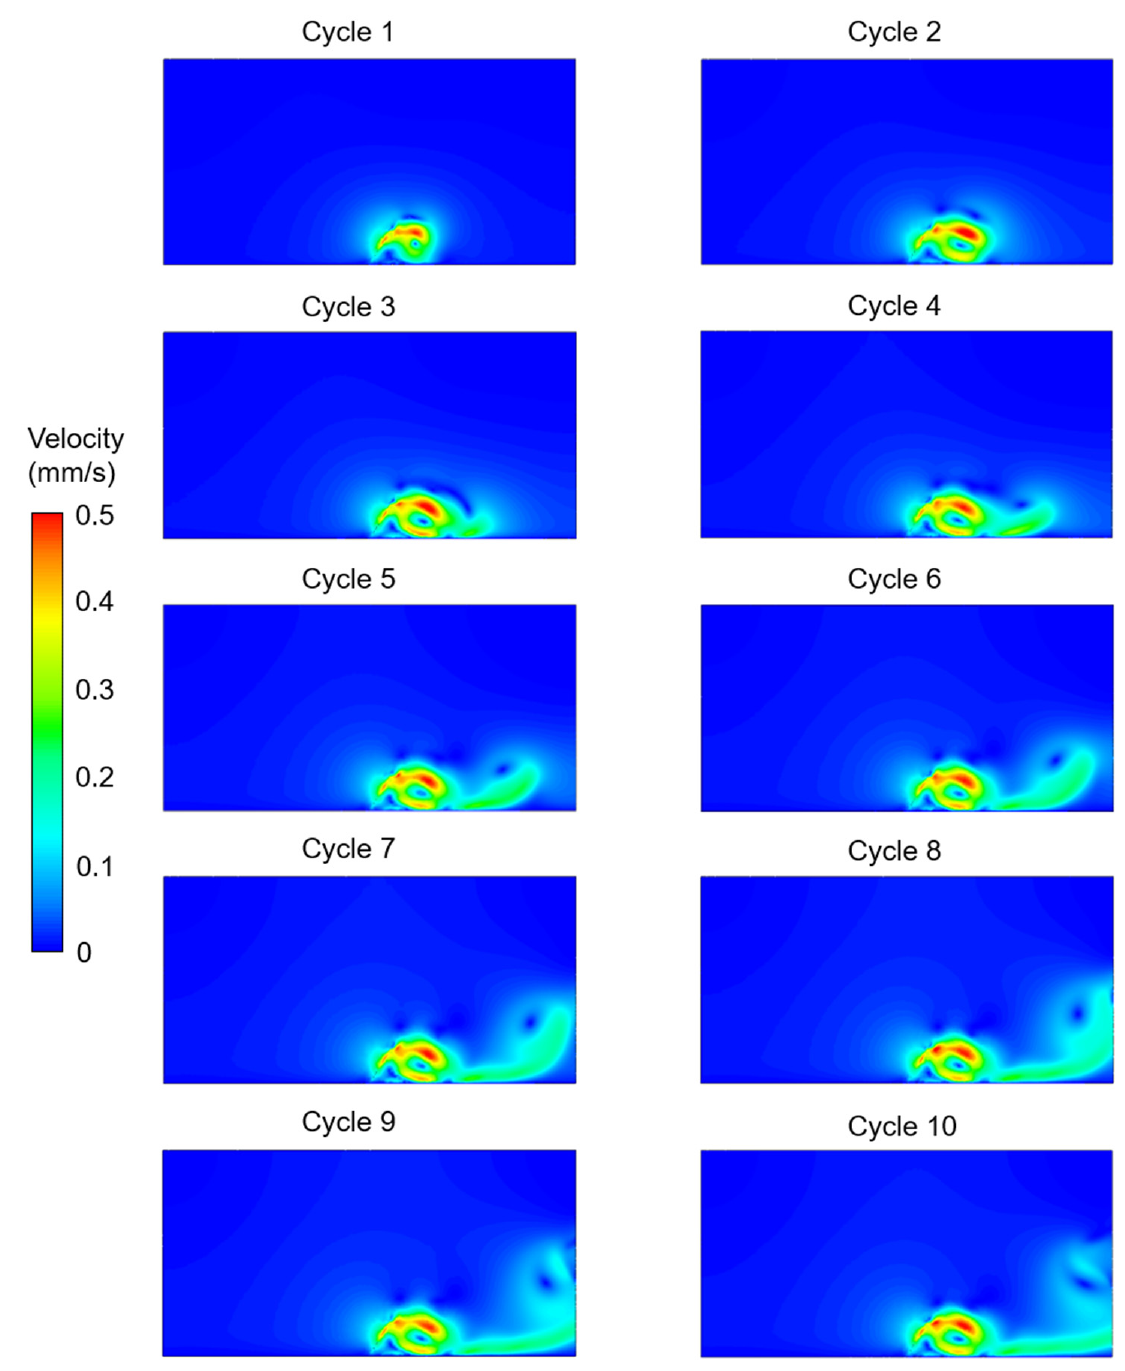
Figure 5. Velocity contour plots of Case 3 for a single cilium with a 60° cilium tilt angle. The flow fields are provided at the end of each ciliary cycle.